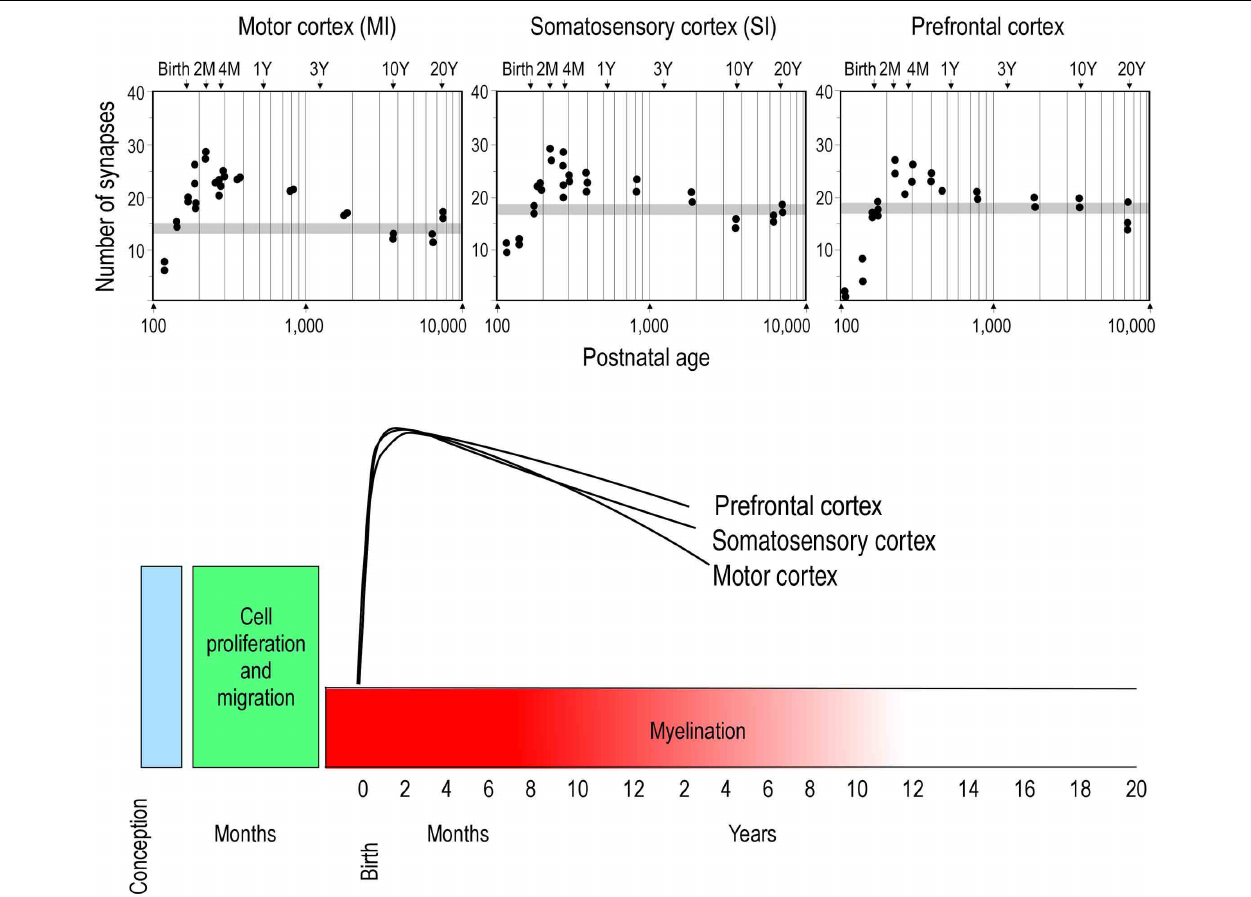
FIGURE 1 | Concurrent synaptogenesis. Plots illustrating the density of synapses per 100 μ m of cortical neuropil in the primary motor (MI) and somatosensory (SI) areas and ventrolateral prefrontal cortex (Brodmann’s area 12) of the macaque monkey. The average synaptic